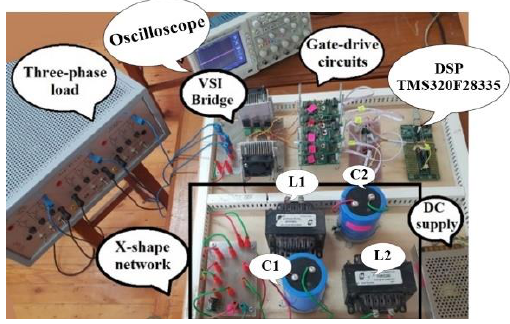
Figure 10. X-shaped impedance source inverter test reg.